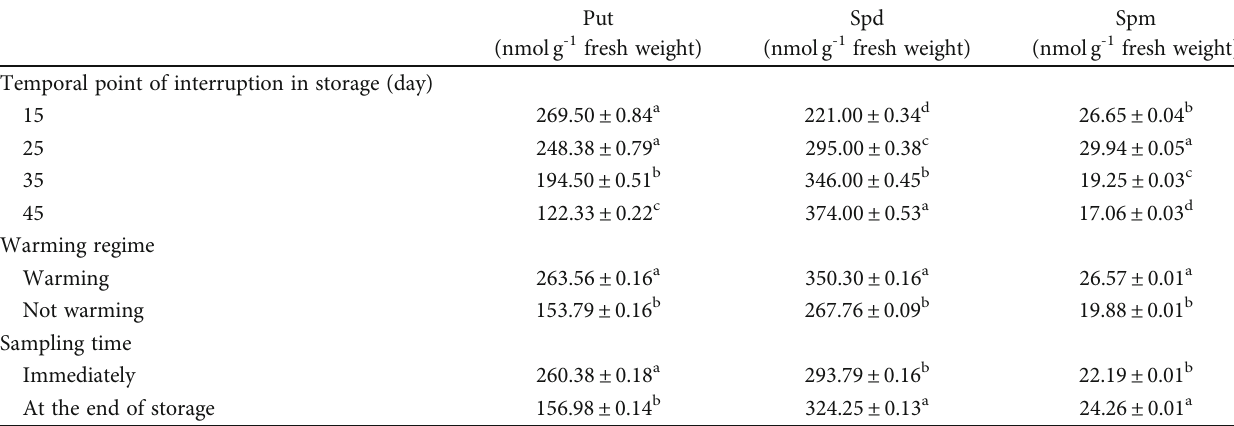
Table 4: E ff ects of experimental factors on the content of polyamines (PAs) in the peel of cold-stored pomegranate.